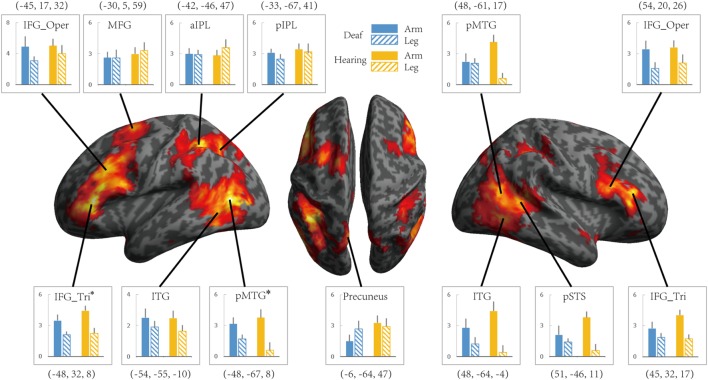
Areas recruited in action understanding (contrast Action Judgment Task > Red Dot Task) in Experiment 1 for all participants (FDR q < 0.05). ROIs were defined using the same contrast but at a stricter threshold (FWE P < 0.05). The blue and yellow bars depict beta estimates in the hearing and deaf group, respectively. Solid and slash bars represent the arm and leg actions, respectively. Asterisk indicates significant main effect between arm and leg condition. (P < 0.004, significant at Bonferroni corrected 0.05 for multiple comparison across 13 ROIs).